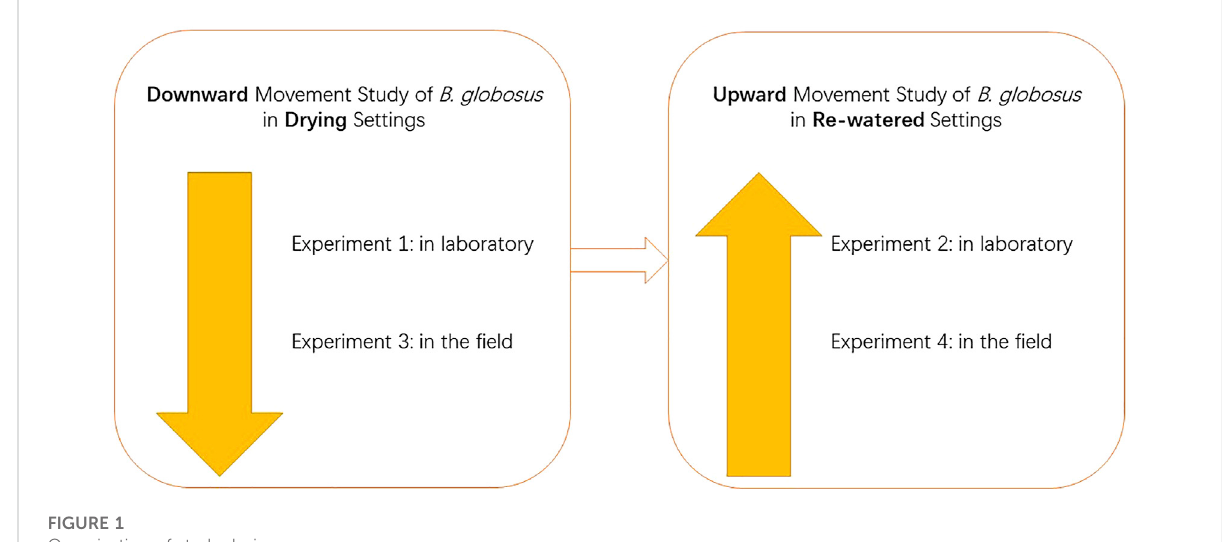
FIGURE 1 Organization of study